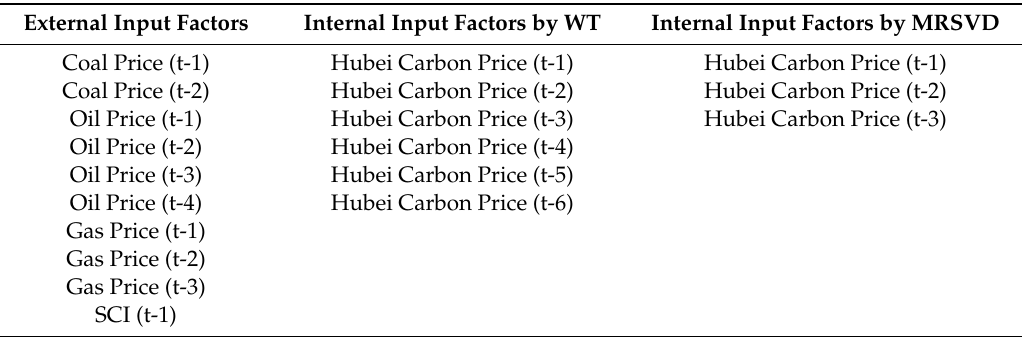
Figure 15. The PCAF results of Hubei carbon price after MRSVD. Table 7. The results of external and internal input factors selection for Hubei carbon price forecasting.